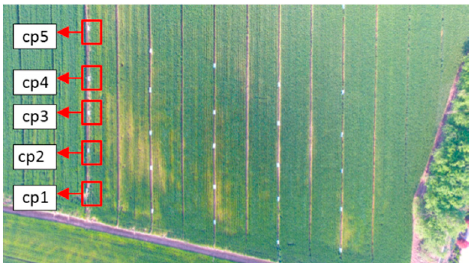
Figure 3. The distribution of ground control point makers in the HLB